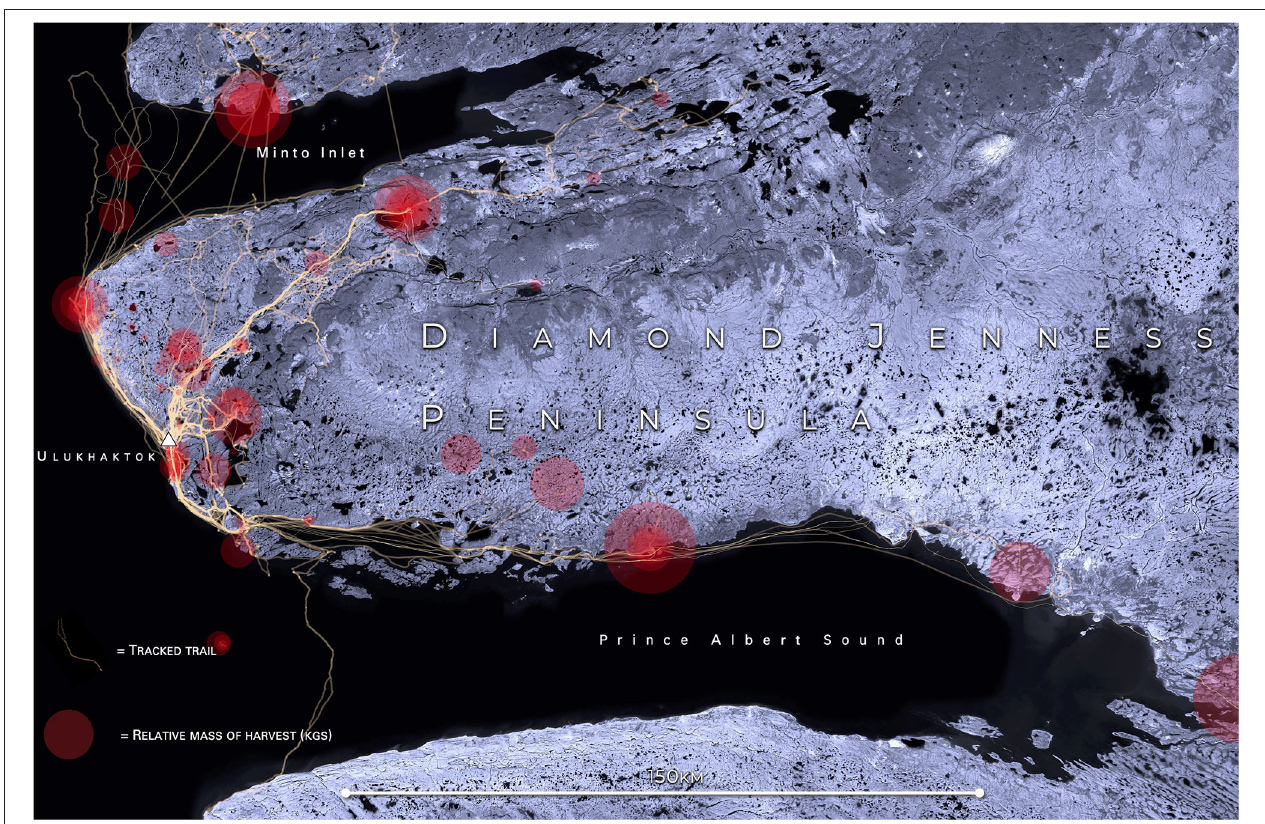
FIGURE 2 | Tracked GPS and annotated routes collected as part of the Tooniktoyok project, Jan–Dec 2019. Thickness of lines corresponds to frequency of trail use. Red circles indicate approximate location of harvests, with size corresponding to relative mass of standard edible weight derived. Trails for unsuccessful harvests are also shown. Basemap: Esri World Imagery (Attribution: Esri, Maxar, GeoEye, Earthstar Geographics, CNES/Airbus DS, USDA, USGS, AeroGRID, IGN, and the GIS User